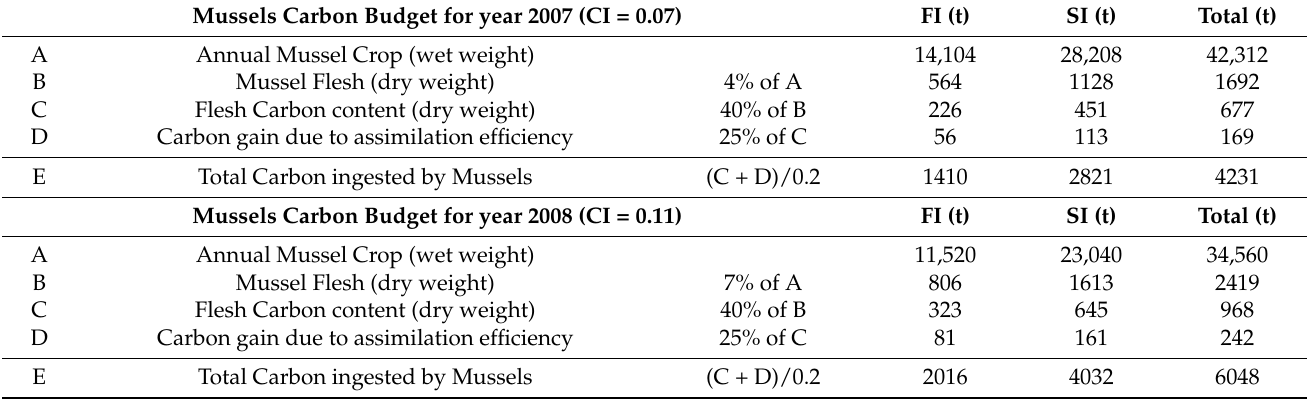
Table 1. Top-down calculation for mussel Carbon budget estimated from annual harvesting data (modified from Caroppo et al. [22]) in the First and Second Inlet (FI and SI) of MP. Mussel physiological data for the years 1990 and 2007–2014 served as proxies to estimate the values of flesh dry weight (B) and the relative percentage of Carbon content values (C). The total Carbon ingested by mussels (E) is expressed as the sum of the Carbon content of flesh dry weight (C) and the quote of Carbon due to mean assimilation efficiency (D, percentages are from Brigolin et al. [47]) together divided by 0.2 representing the trophic efficiency parameter